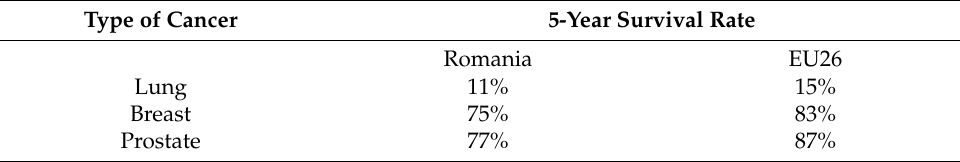
Table 1. The five-year survival rates from main types of cancer (Romania versus